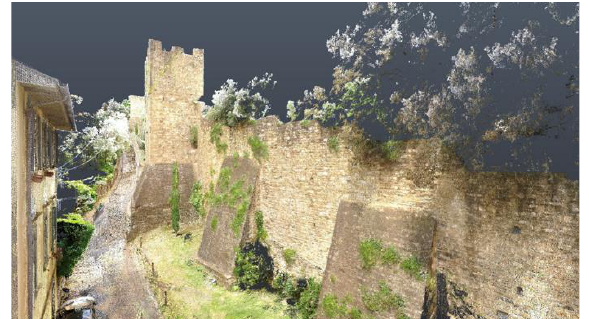
Figure 6. Point cloud detail of the section under examination